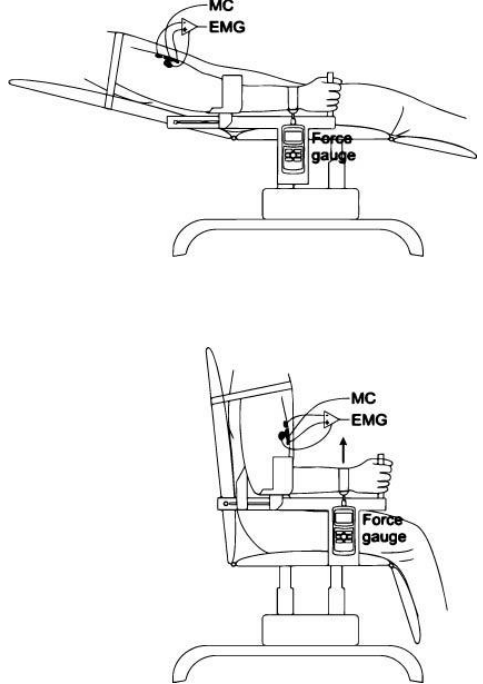
Figure 2. Measurement setup. Measurements were performed at two different elbow angles: 15° and